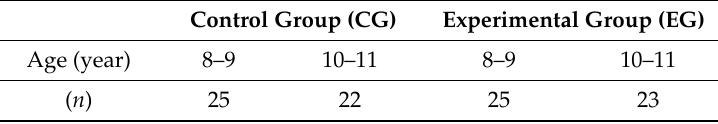
Table 1. Depiction of the sample according to age and